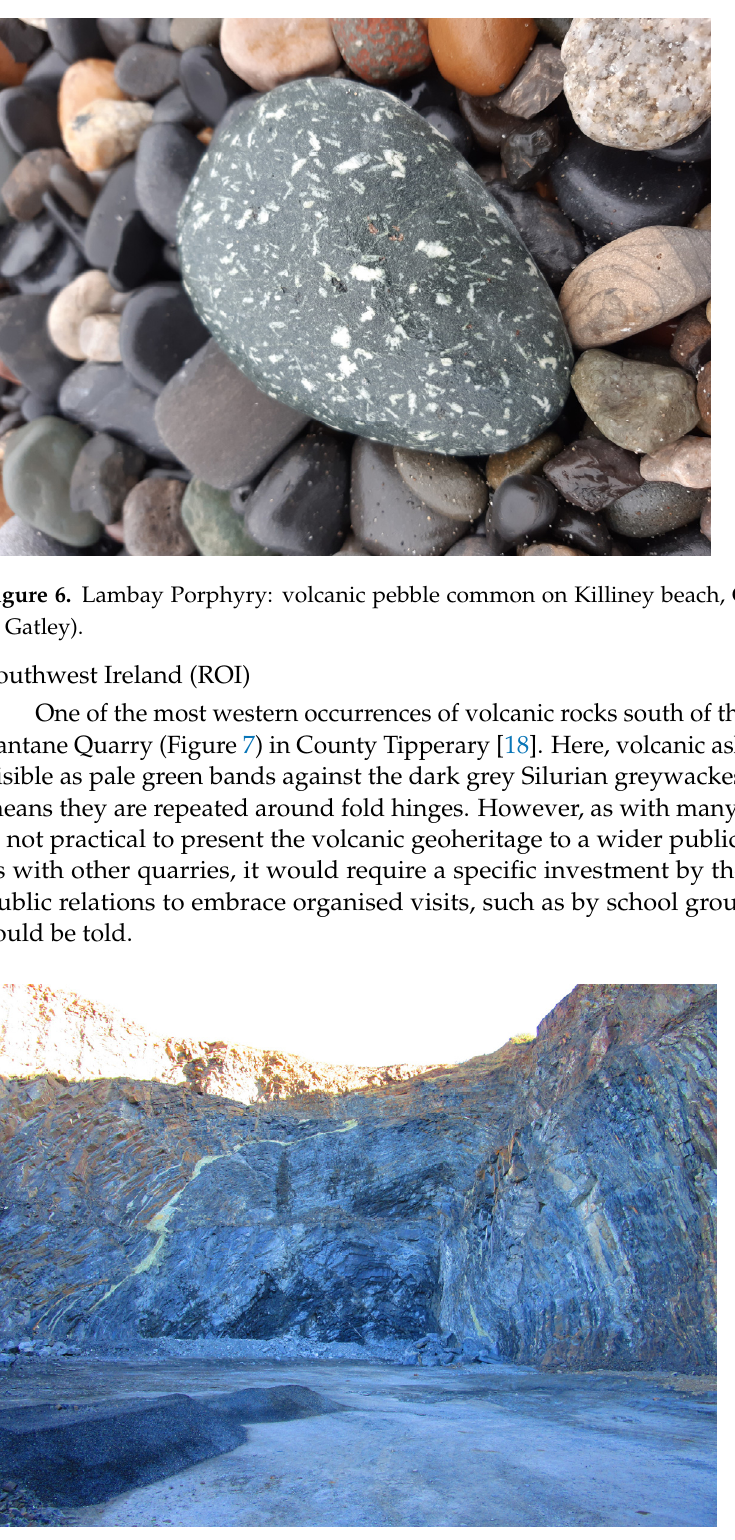
Figure 7. Fantane Quarry, County Tipperary: pale green volcanic ash bands in Silurian grey-wackes.